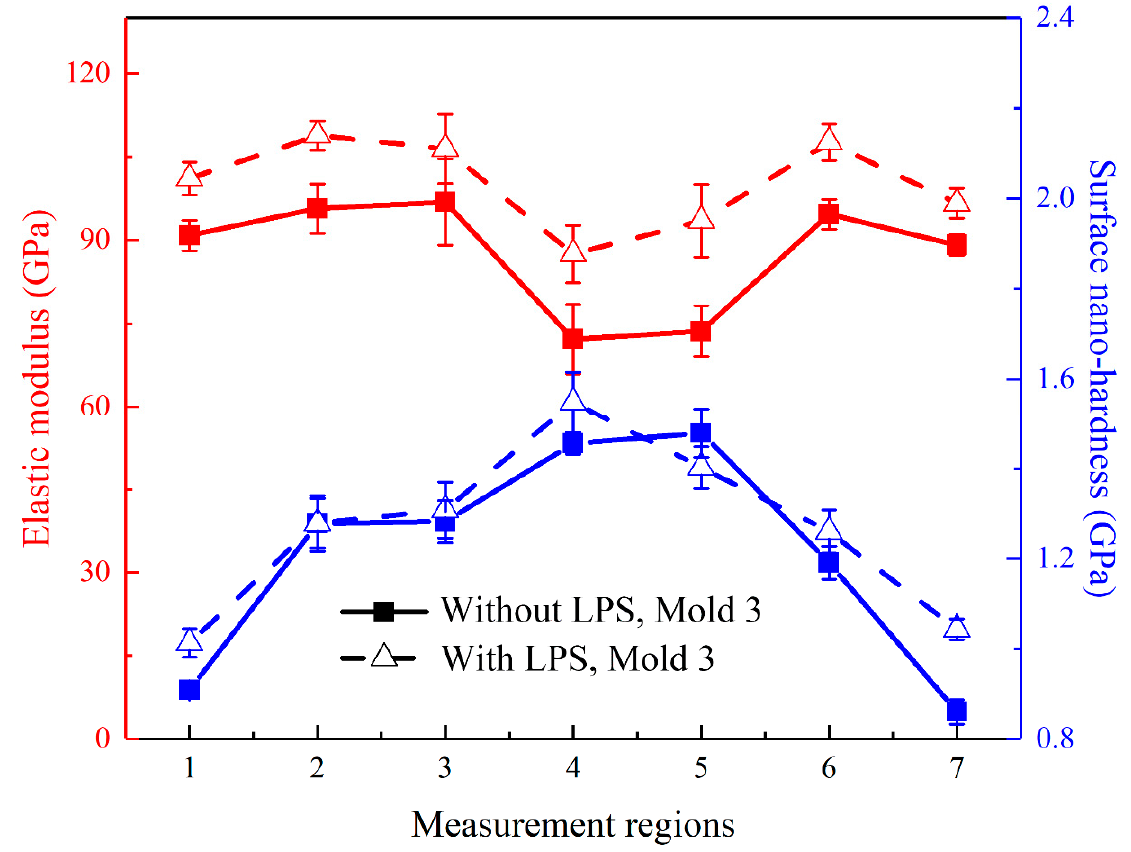
Figure 17. Surface nano-hardness and elastic modulus of different regions of bulging samples.